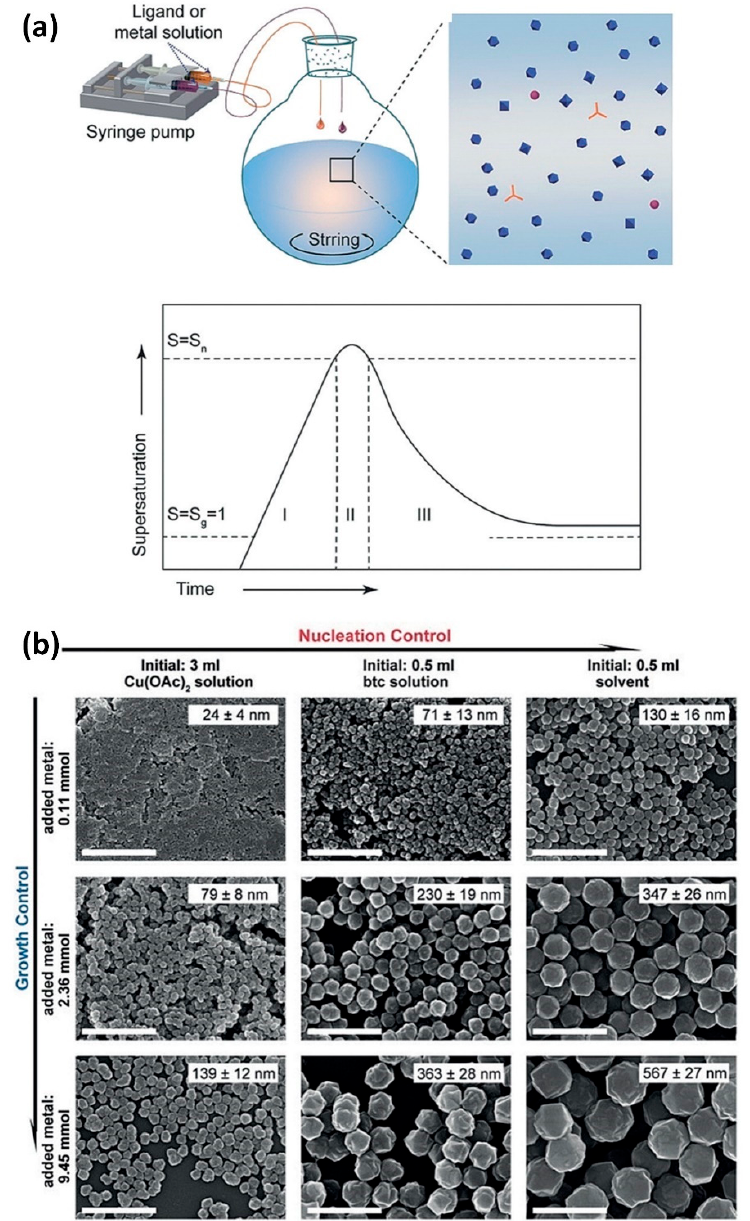
Figure 1. ( a ) Diagram illustrating the process and mechanism of preparing nanoMOFs. ( b ) SEM images of nanoHKUST–1 crystals prepared by different experiment parameters. Scale bar is 1 µm. Reproduced from Ref. [72] with permission from Wiley–VCH, copyright 2018.